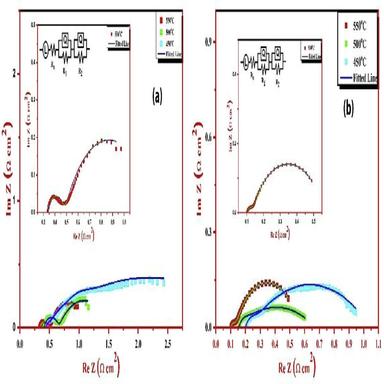
(a) EIS spectra of BZY and (b) La-doped BZY electrolyte under H2/air environments at 450e550 C.